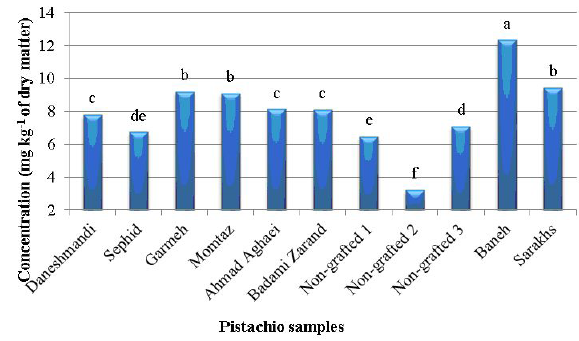
Fig. 7. The copper concentration of eleven Iranian pistachio samples. (Each column with different letters is significantly dif- ferent (P < 0.05)